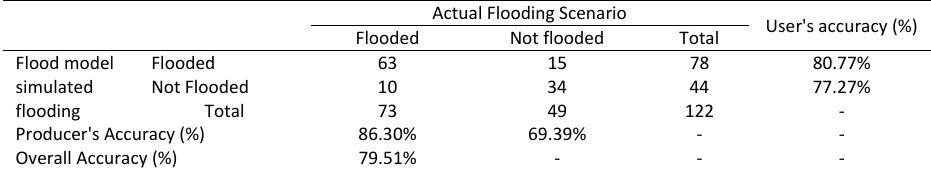
Table 4: Result of the flood map accuracy analysis in Maradugao River Basin for Typhoon Sendong (Washi) event